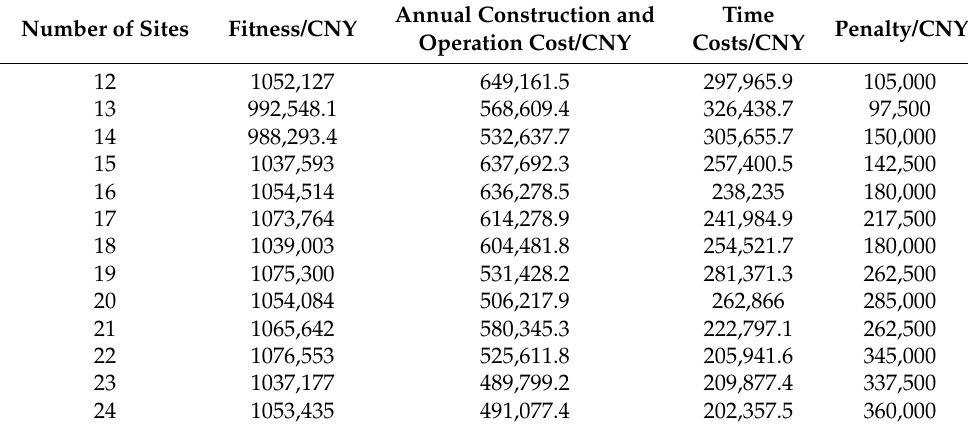
Table 6. Costs for different number of sites.